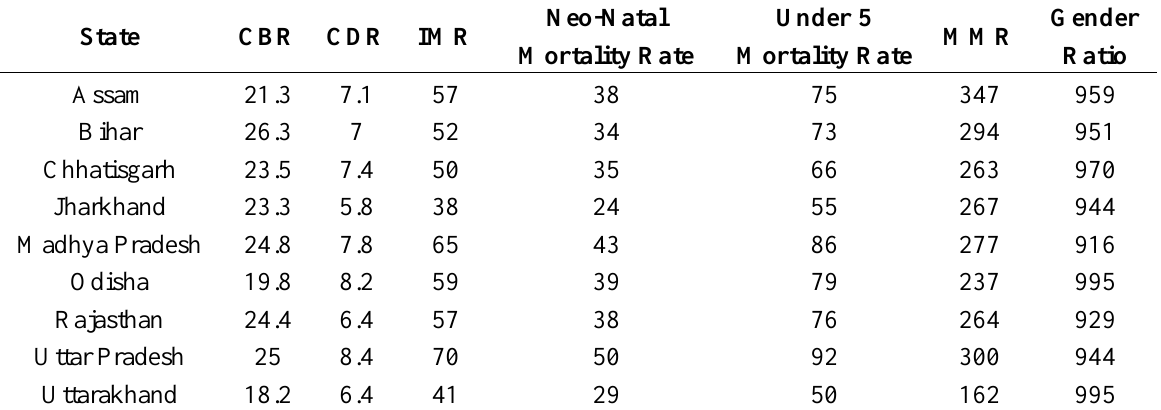
Table 3. Health indicators of nine states as obtained from the Annual Health Survey (AHS) Second Round Survey,